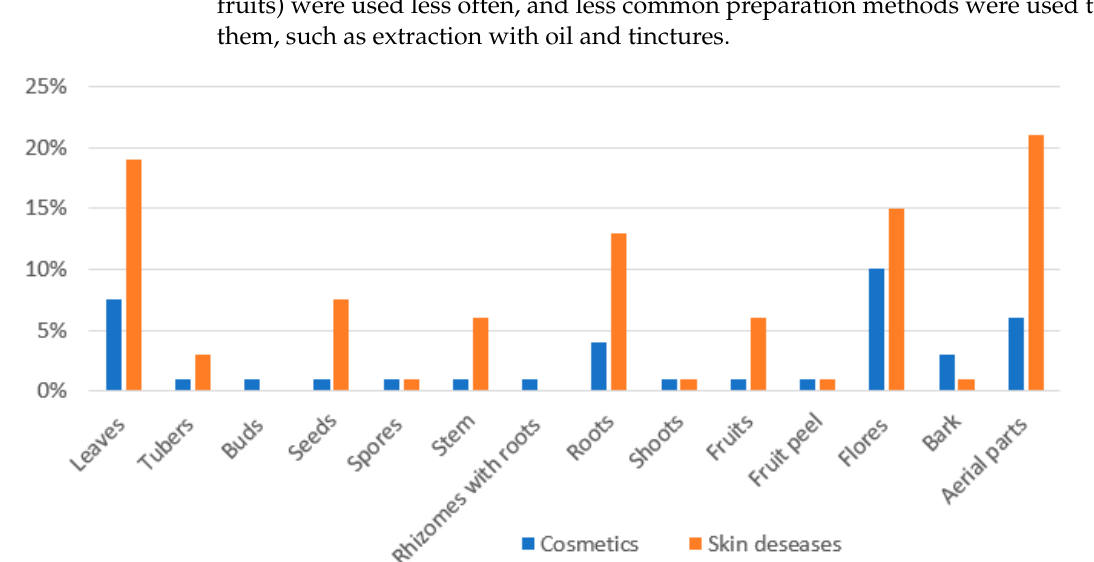
Figure 5. Parts of the plants used for ethnopharmaceutical preparations for skin diseases and cosmetics.